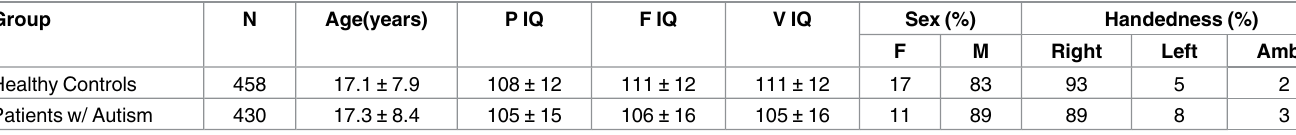
Table 3. Details of Training Datasetparticipants, ABIDE.